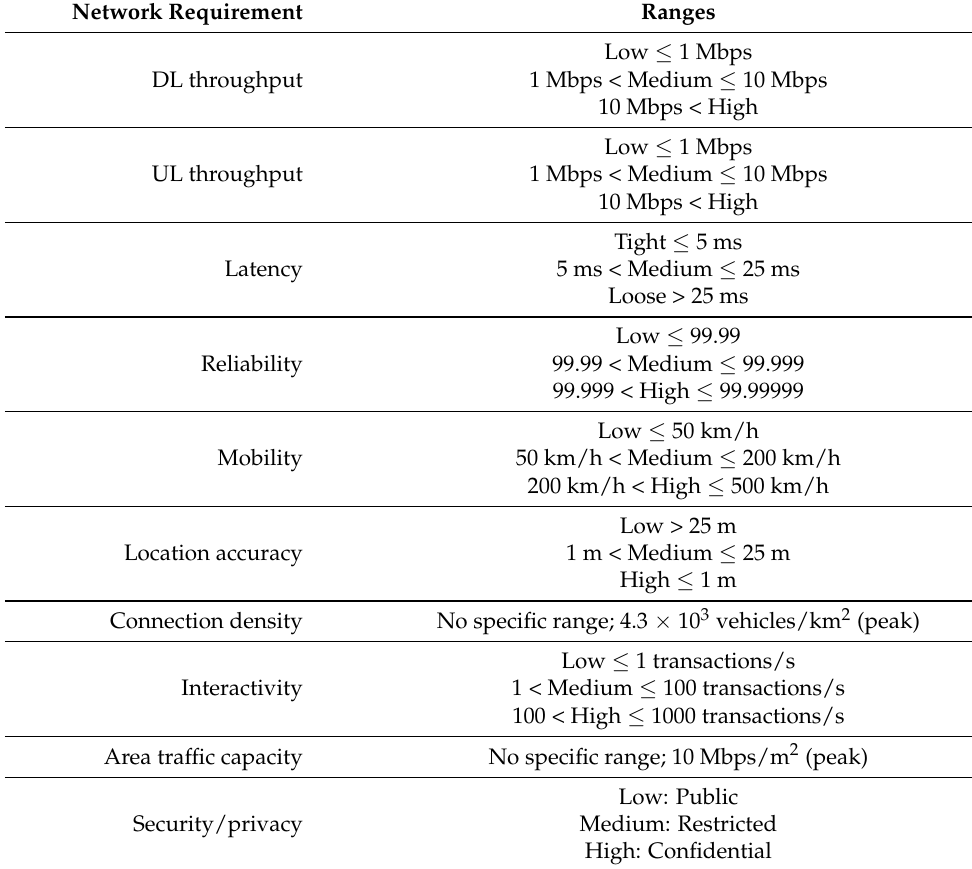
Table 1. Qualitative characterization of network